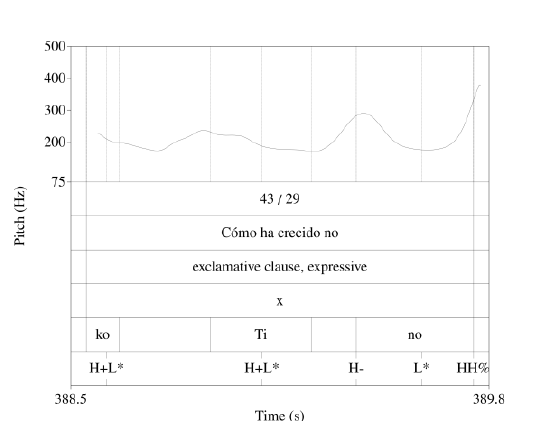
Figure 2. ¡Cómo ha crecido!, ¿no? pronounced with a sharp rising contour over the tag